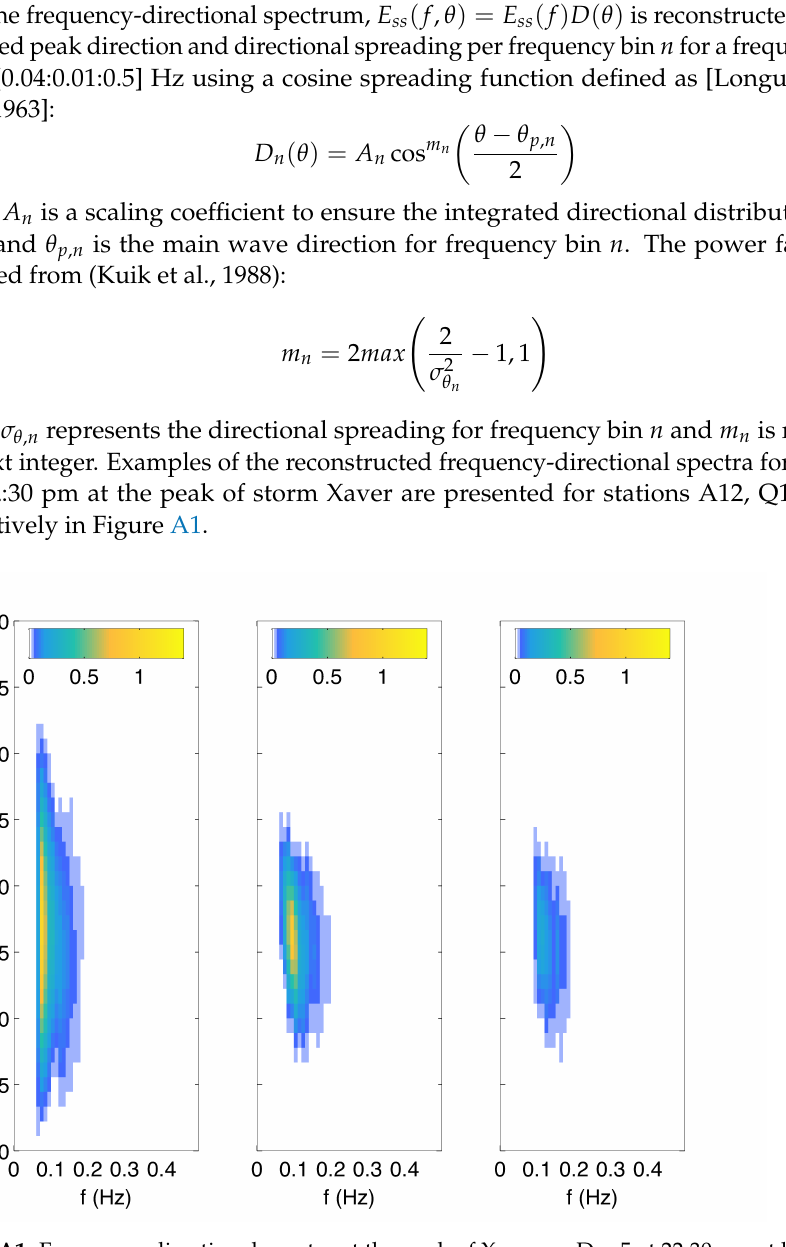
Figure A1. Frequency-directional spectra at the peak of Xaver on Dec 5 at 22:30 pm at location A12 (left panel), at Q1 (middle panel) and EUR (right panel). Directions are defined with respect to north using the nautical convention. Color bar represents variance density in m 2 /Hz/ ◦